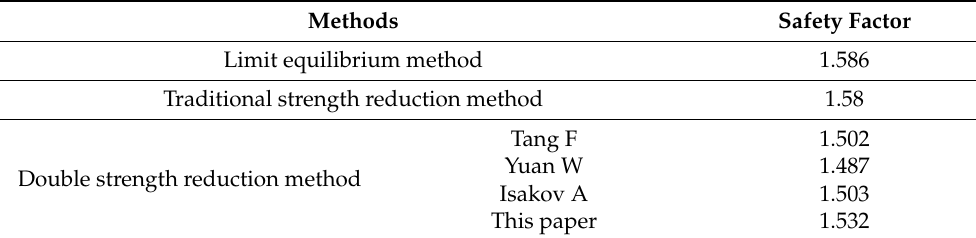
Table 2. Safety factors calculated by several slope stability analysis